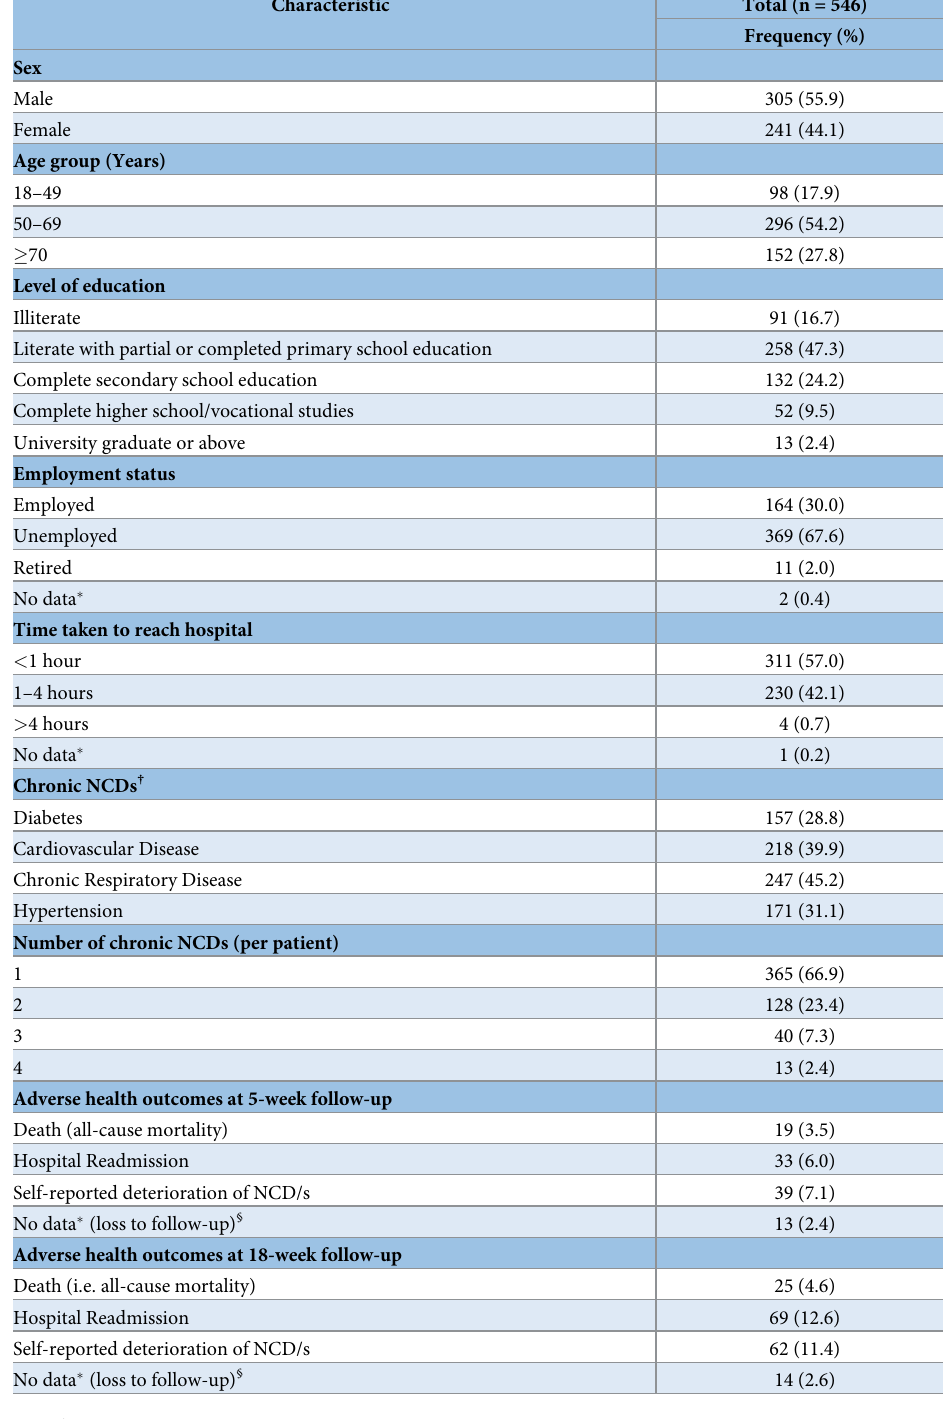
Table 1. Participant demographic and adverse health outcomes